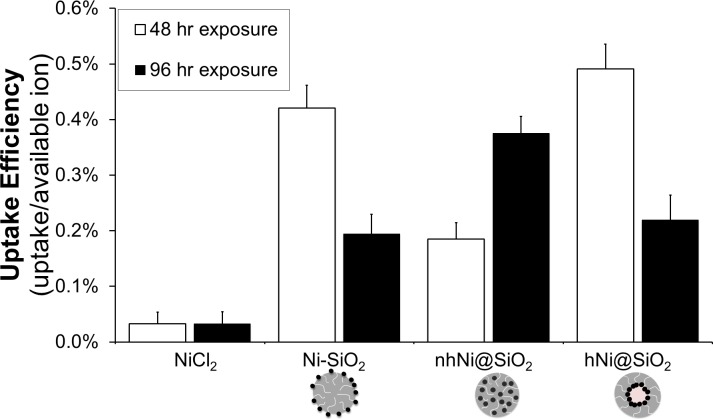
Zebrafish uptake efficiency of NiCl2 and CENs after 50 mg Ni/L exposure for 48 hours and 96 hrs.